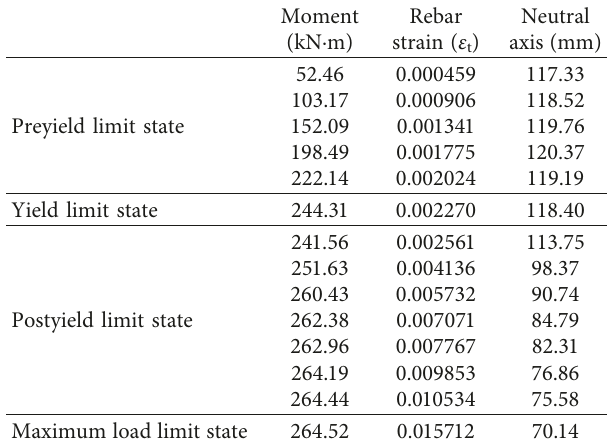
Table 9: Analytical moment-strain relationship (Specimen #1) [19].